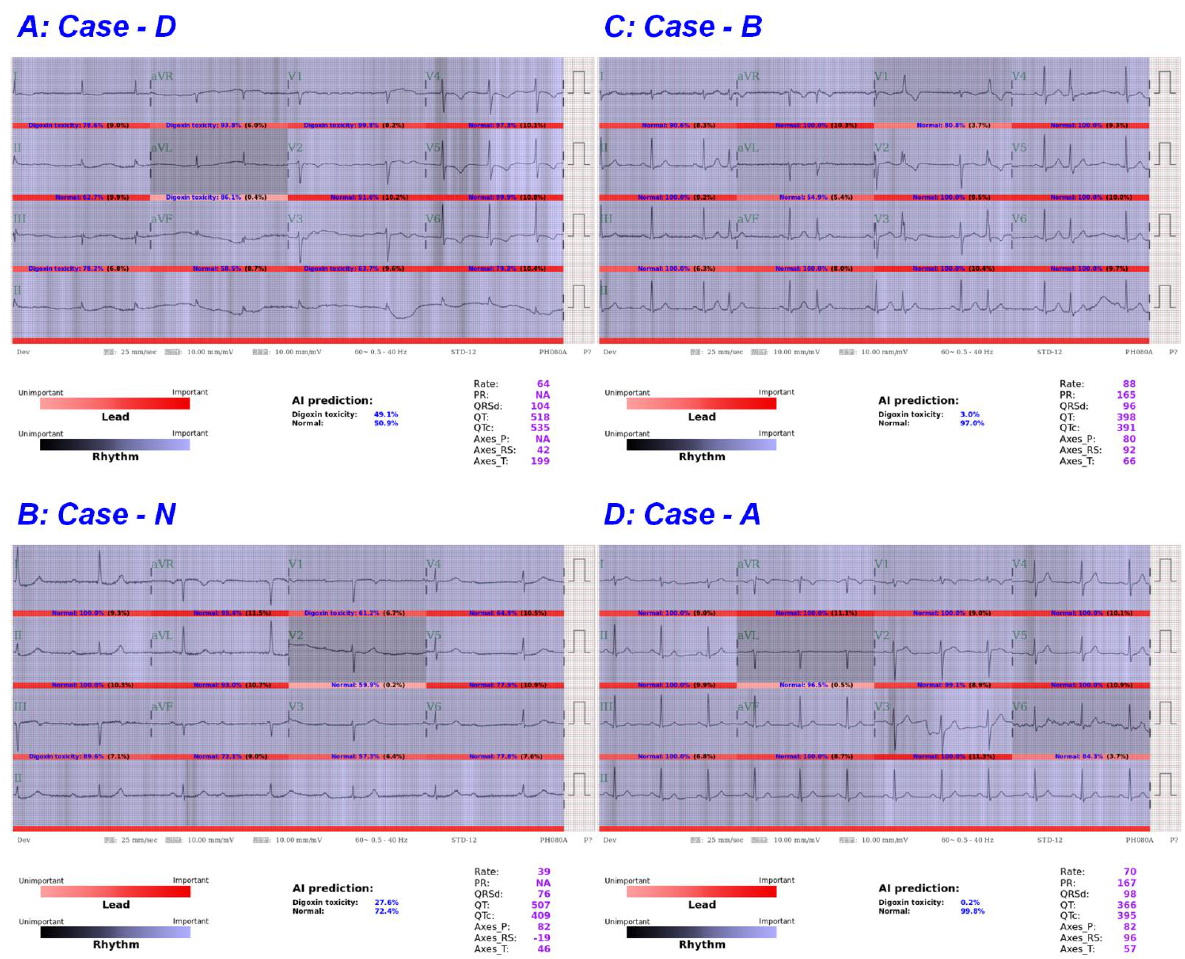
Figure 2. Selected ECGs (electrocardiographies) of consistent and inconsistent assessments given by the deep learning model and the human experts. ( A ) The ECG was correctly identified as high risk of digoxin toxicity by both human experts and AI machine. ( B ) The ECG was correctly identified as low risk of digoxin toxicity by AI machine, but not by human experts. ( C ) The ECG was correctly identified as high risk of digoxin toxicity by human experts, but not by AI machine. ( D ) The ECG has been misdiagnosed by both human experts and AI machine.